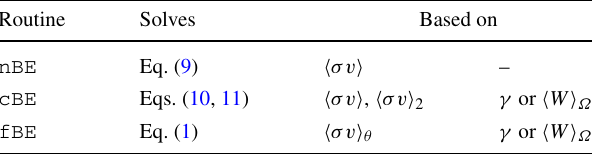
Table1 Thenamesofthethreeroutines solving ,respectively,theBoltz- mann equation referred to in the second column. The third and fourth column show the basic quantities that these equations are based on. These routines are, respectively, located in the files nBE.wl , cBE.wl and fBE.wl (in the src/ directory)